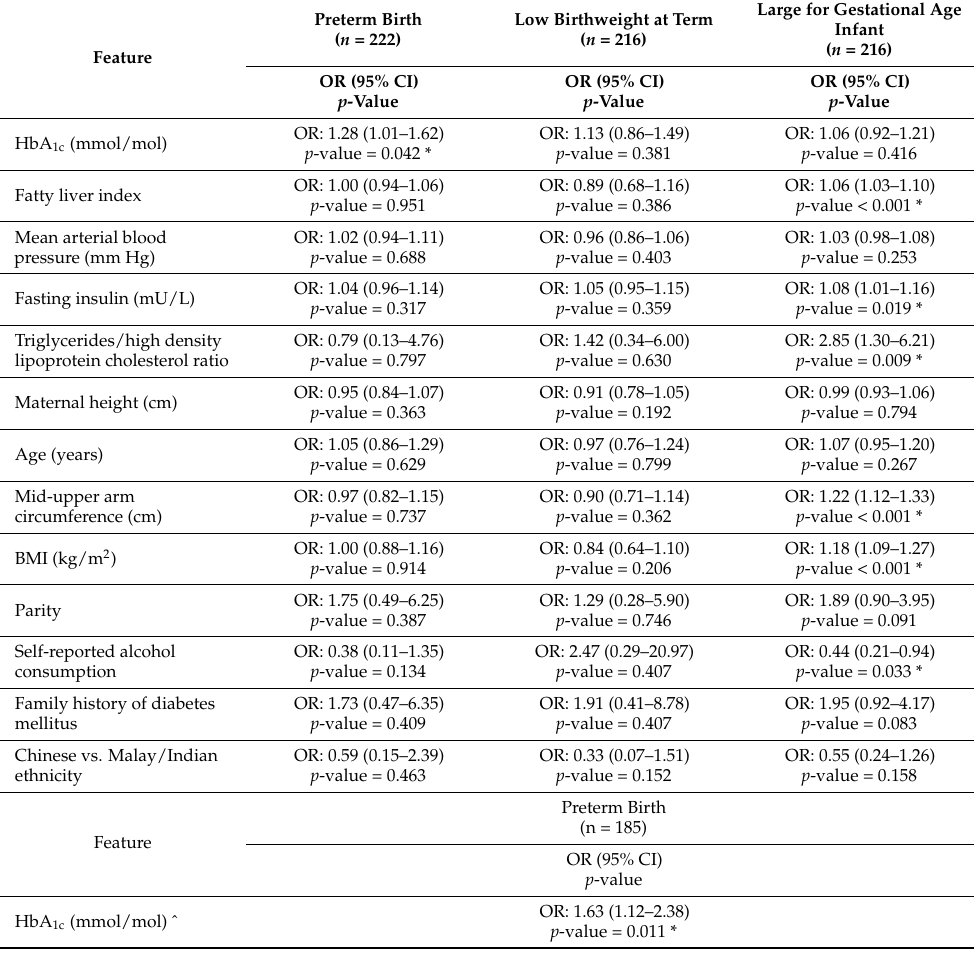
Table 4. Associations of top predictors and adverse birth outcomes (preterm birth, low birthweight at term and large for gestational age infant). Associations of top predictors identified from AutoML feature selection model and adverse birth outcomes (preterm birth, low birthweight at term and large for gestational age infant). Statistical tests were conducted two-sided with a significance level of 5%. All confidence intervals (CIs) are presented two-sided with a confidence level of 95%. The odds ratios (ORs) with 95% CI are presented. A resultant p -value of less than 0.05 is considered statistically